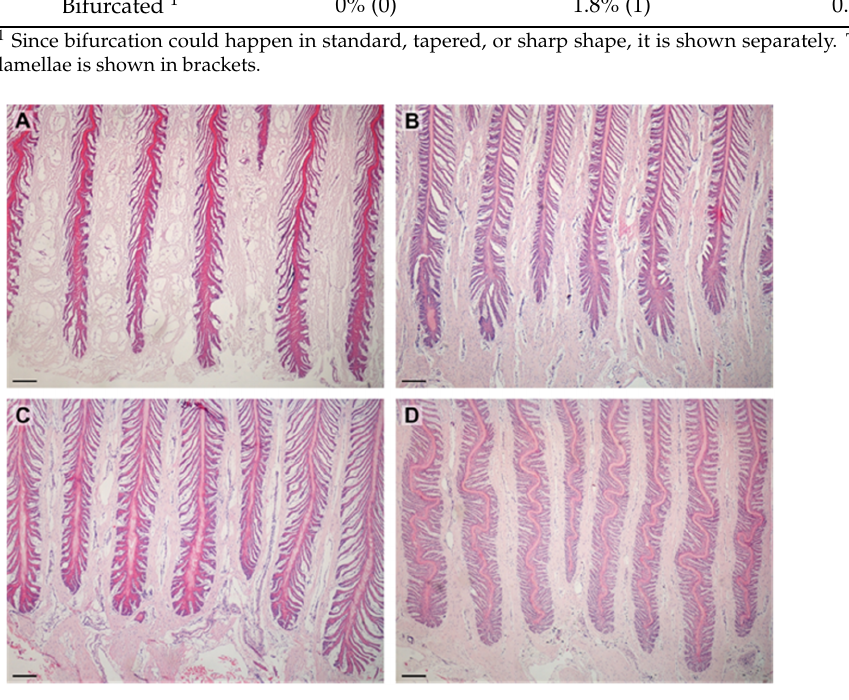
Figure 2. Images show PELs in examined horses. PELs did not differ between groups: ( A )—sharp PELs in obese horse; ( B )—sharp PELs in lean horse; ( C )—standard PELs in obese horse; ( D )—standard PELs in lean horse. Scale bar = 200 µm.